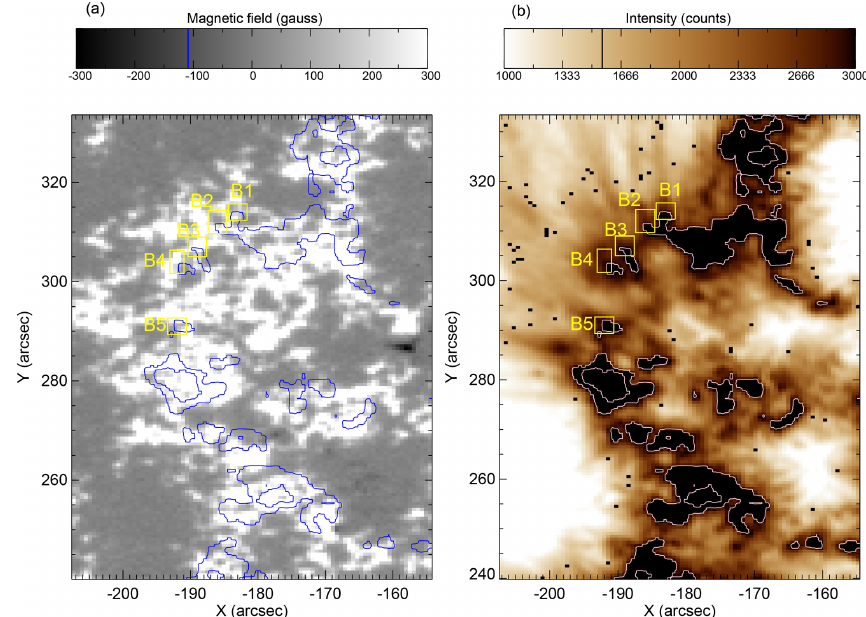
Figure 3. (a) HMI map indicating the magnetic polarities at the moss region, indicted by blue contours. (b) Identification of the foot points of quiescent loops anchored at the moss regions. The different small boxes that are taken at the foot points of the individual loop strands are shown in both the